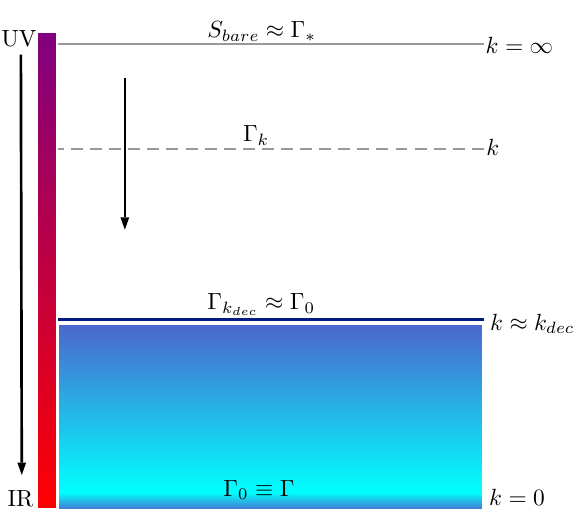
Figure 1 . Idea behind the decoupling mechanism. If one or a combination of physical IR scales in the effective average action overcomes the effect of the regulator R the flow freezes out and the effective average action at the critical scale k effective action Γ 0